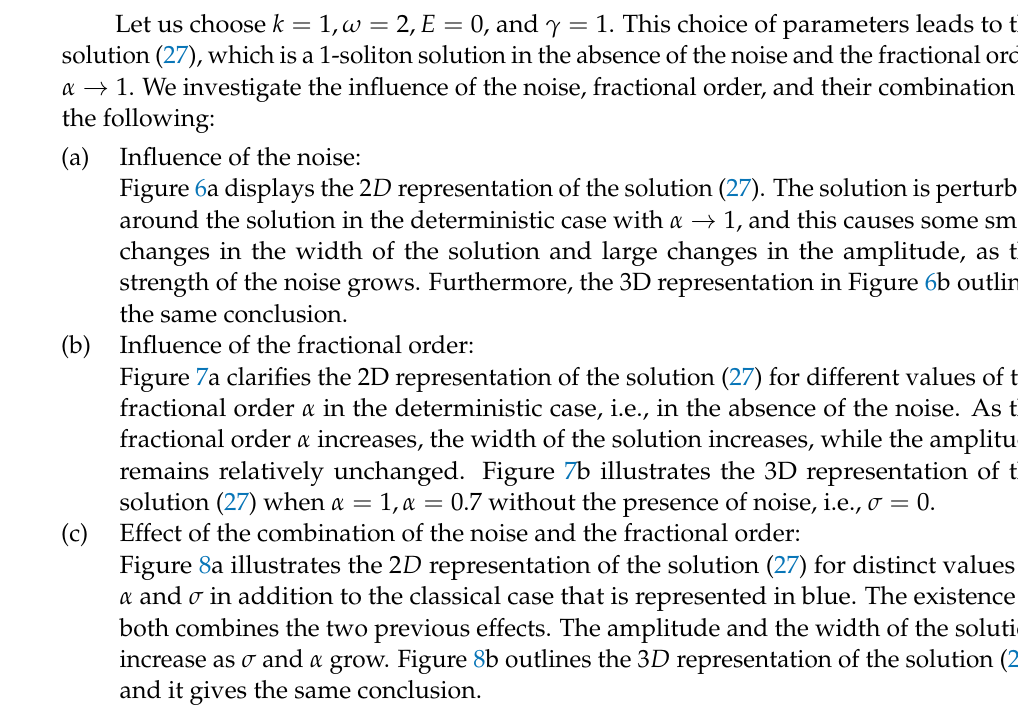
Figure 5. The combined effect of the noise and the fractional order α on the solution (19).